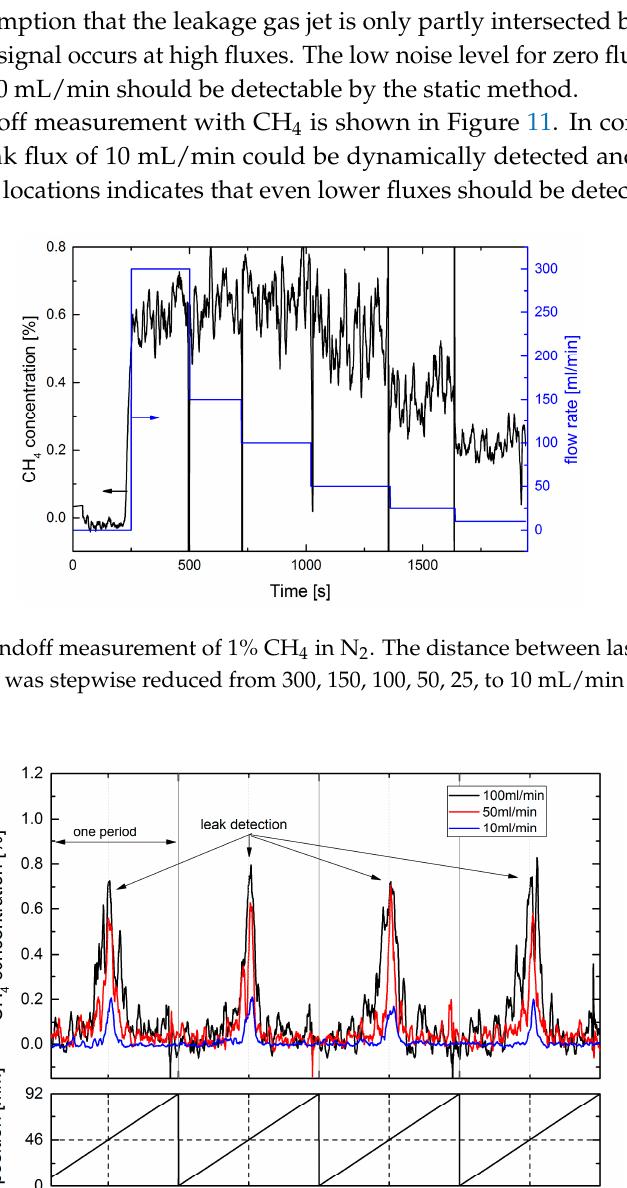
9 of 14 Figure 9. Standoff dynamic N 2 leak detection via measurement of the O 2 concentration. The distance between the laser and leak plate was 55 cm. The leak plate was horizontally moved by a sliding stage with a speed of 0.2 mm/s in a sawtooth manner, as indicated by the lower figure. The leak position is at 46 mm. N 2 fluxes of 100 mL/min could be dynamically detected and localization of the leak is feasible. However, the dynamic detection is significantly less sensitive than the static detection in Figure 8. Furthermore, a fixed pattern noise was observed by moving the laser spot across the diffuse reflecting plate. Increasing the laser spot size by a factor of three did not improve the result.